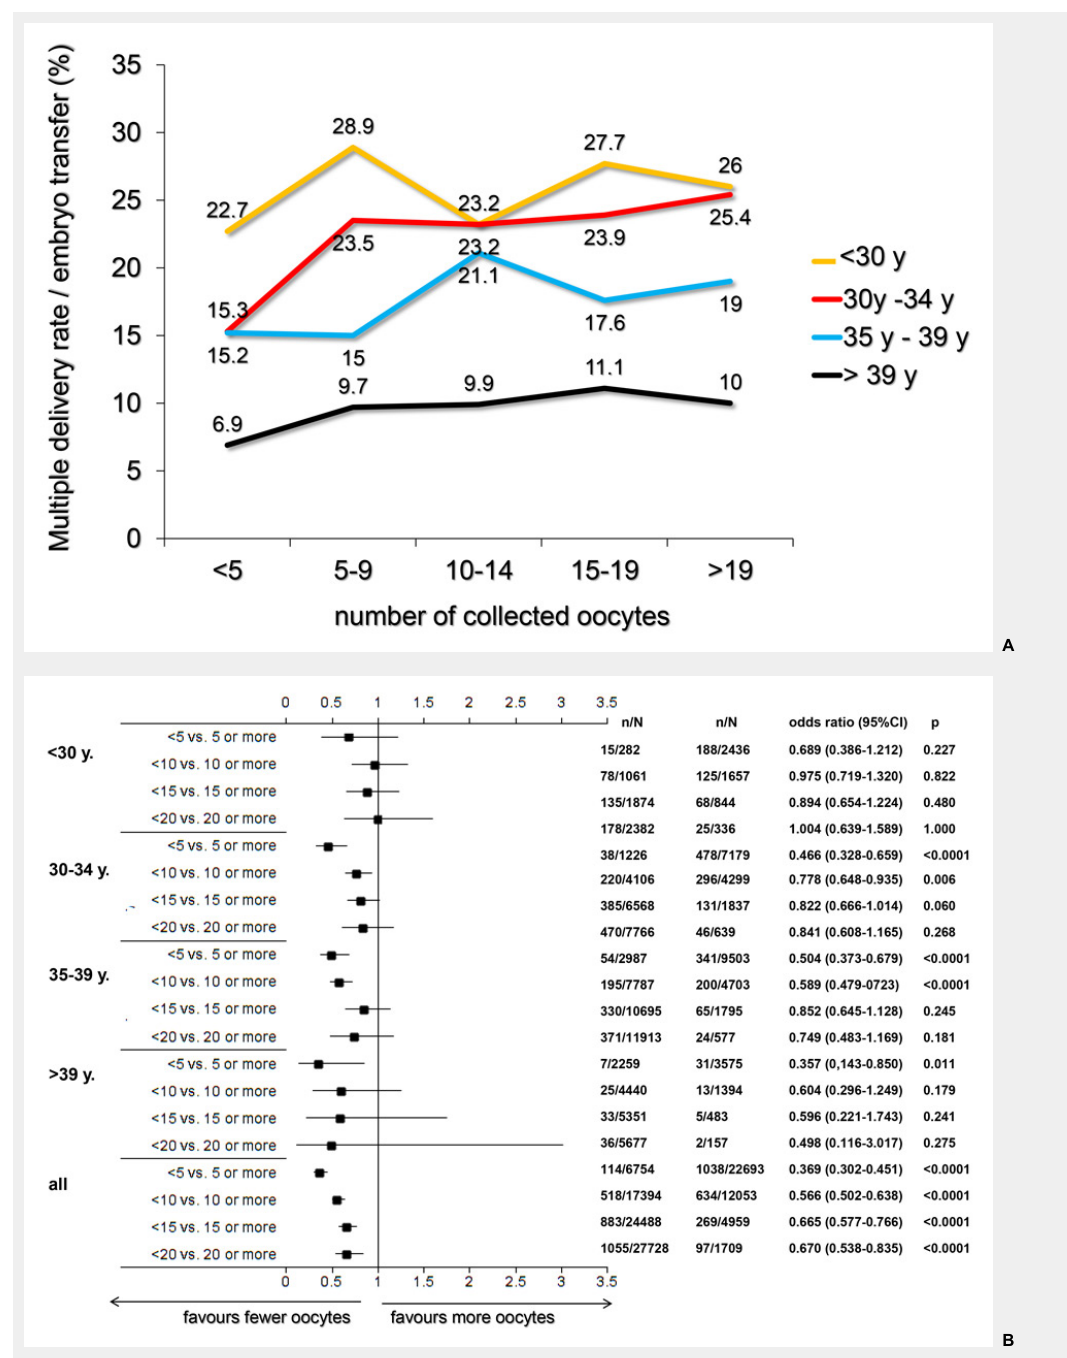
A Using the pooled FIVNAT-CH data, the relationship between the number of retrieved oocytes, the mean age of the treated patients at oocyte collection and the incidence of multiple deliveries was assessed during the observation period from 2005 to 2012. The incidence of multiple deliveries most strongly depended on the age of the treated women and to a lesser extent on the number of collected oocytes. B Number of multiple deliveries and its relationship with the number of collected oocytes and the age of the treated infertile women at oocyte collection, using the pooled FIVNAT-CH data collected between 2005 and 2012. Whereas the incidence of multiple deliveries per embryo transfer was generally lower among women aged 35 years or older, the incidence of multiple deliveries was very significantly age dependent (p <0.0001) and was lower if fewer than five or ten oocytes had been retrieved. Among women younger than 30 years the incidence of multiple deliveries was not related to the number of retrieved